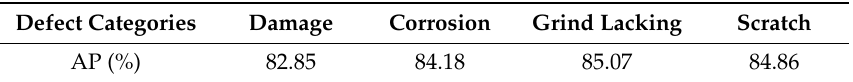
Table 4. AP of each defect